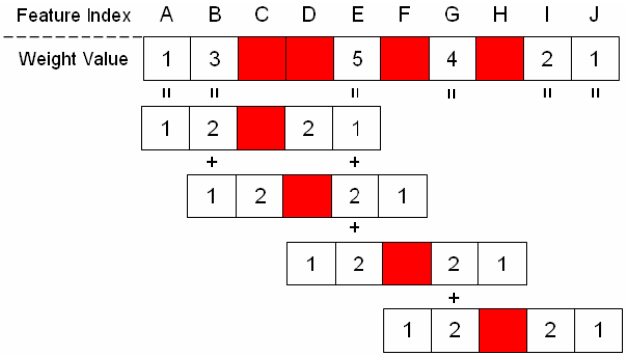
Figure 5. Example of how to calculate the weight values of unselected features.